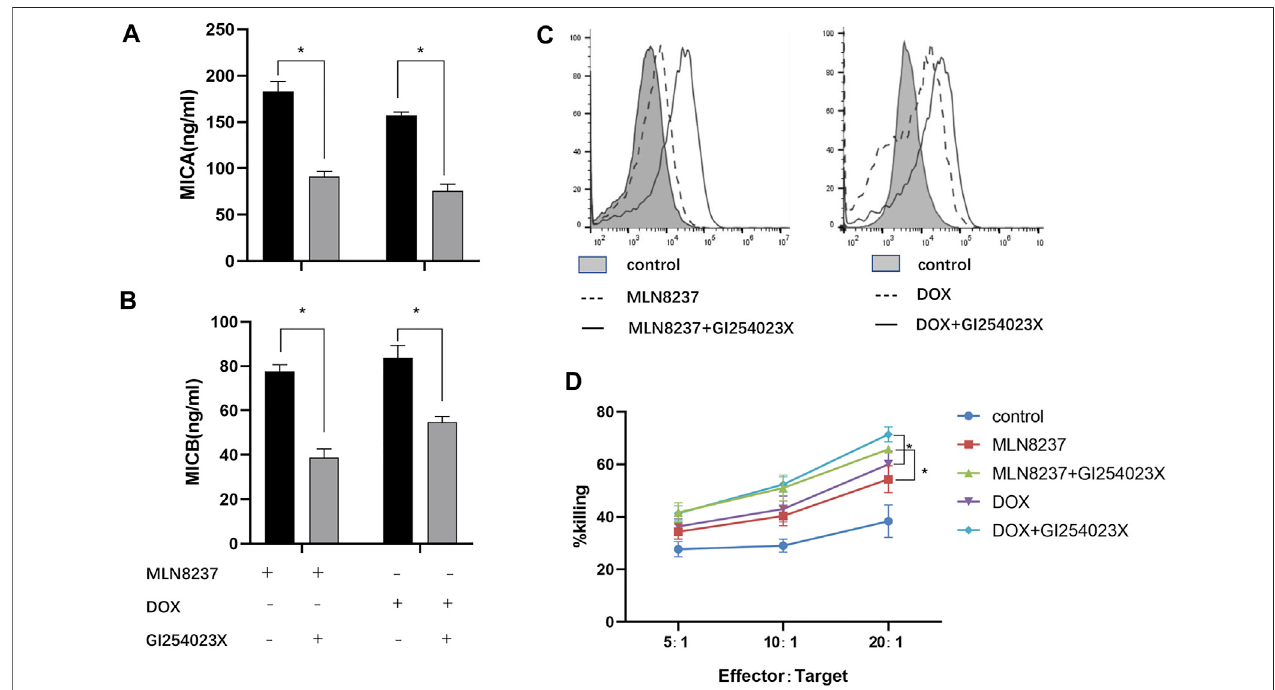
FIGURE 4 | GI254023X combination chemotherapy reduces MICA/B secretion and enhances NK cell recognition. IMR-32 cells were induced to senescence by treatmentwithMLN8237 orDOX,followedbyaddition oftheADAM10 inhibitorGI254023X (5 µM)for72 h.Theexpressionof (A) MICAand (B) MICBinthesupernatant was detected by ELISA. (C) Cell-surface expression of MICA/B was detected by fl ow cytometry following the described treatments. (D) Cells in the different treatment groupswereusedastargetcells,andnormalhumanperipheralbloodNKcellswereusedaseffectorcells.Killingef fi ciencywasdetectedbythecalcein-AMmethod in co-cultures at effector:target cell ratios of 5:1,10:1, and 20:1 for 4 h. Data represent the mean ± SEM of three independent experiments. * p < 0.05.